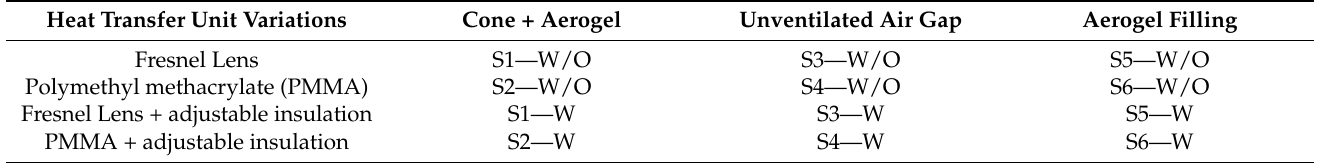
Table 1. Experiment plan. Twelve setup